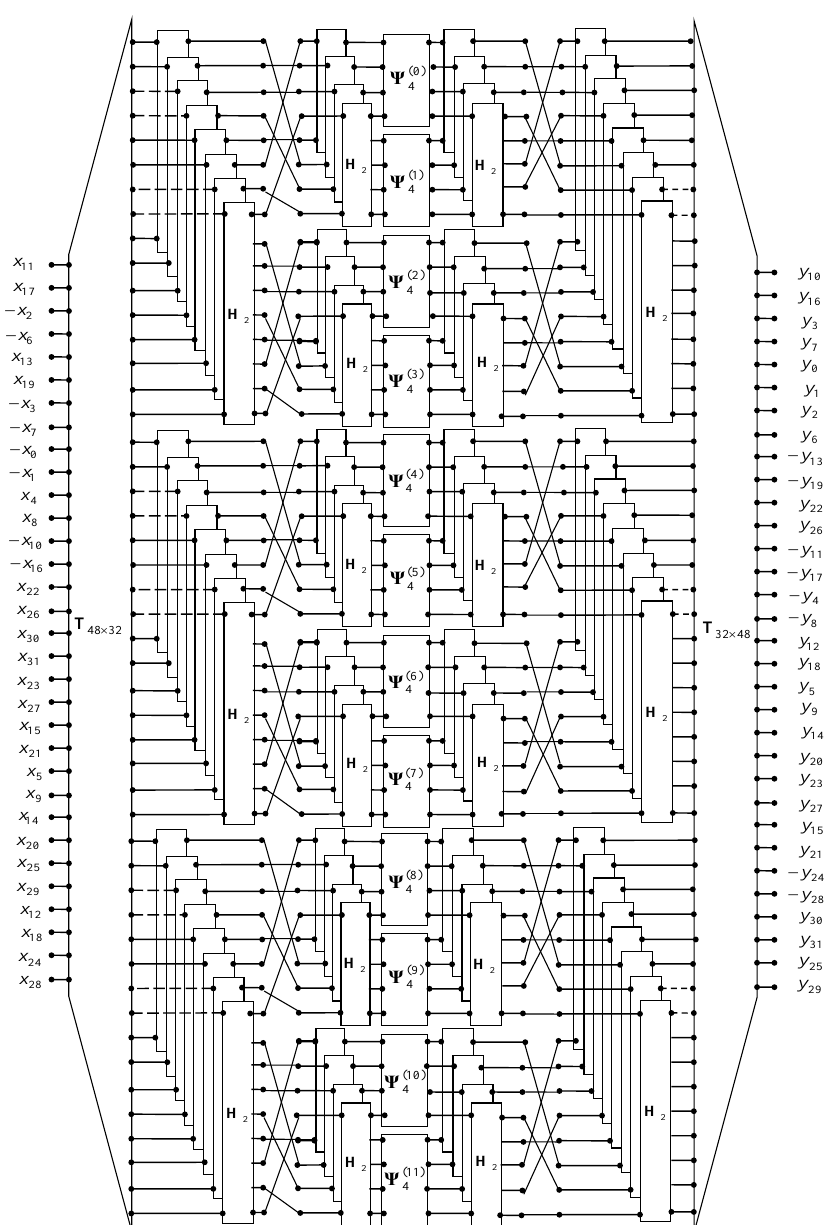
Figure 1. A data flow diagram for the proposed